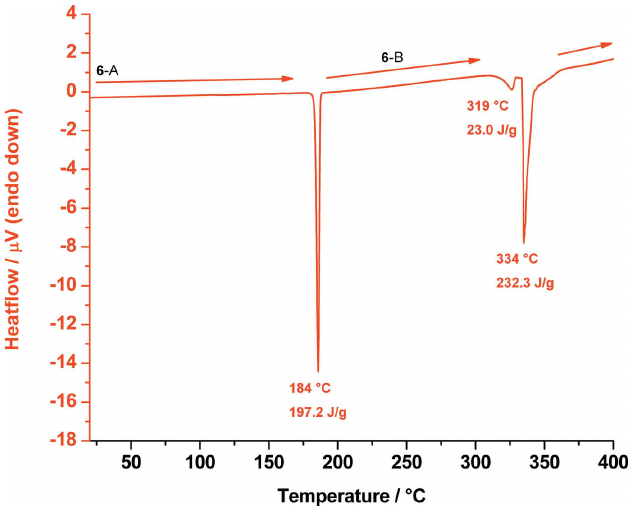
Figure 15 DSC trace of allo -inositol measured from 20 up to 400 (cid:2) C showing the phase transition of polymorph 6 -A to 6 -B at 184 (cid:2) C, melting of 6 -B at 319 (cid:2) C and decomposition at 334 (cid:2)